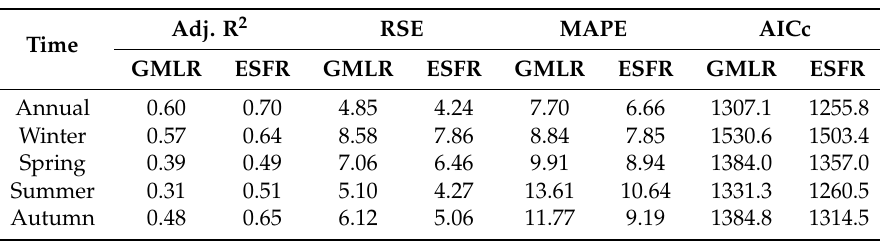
Table 7. Annual and seasonal ESFR model evaluation indicators.